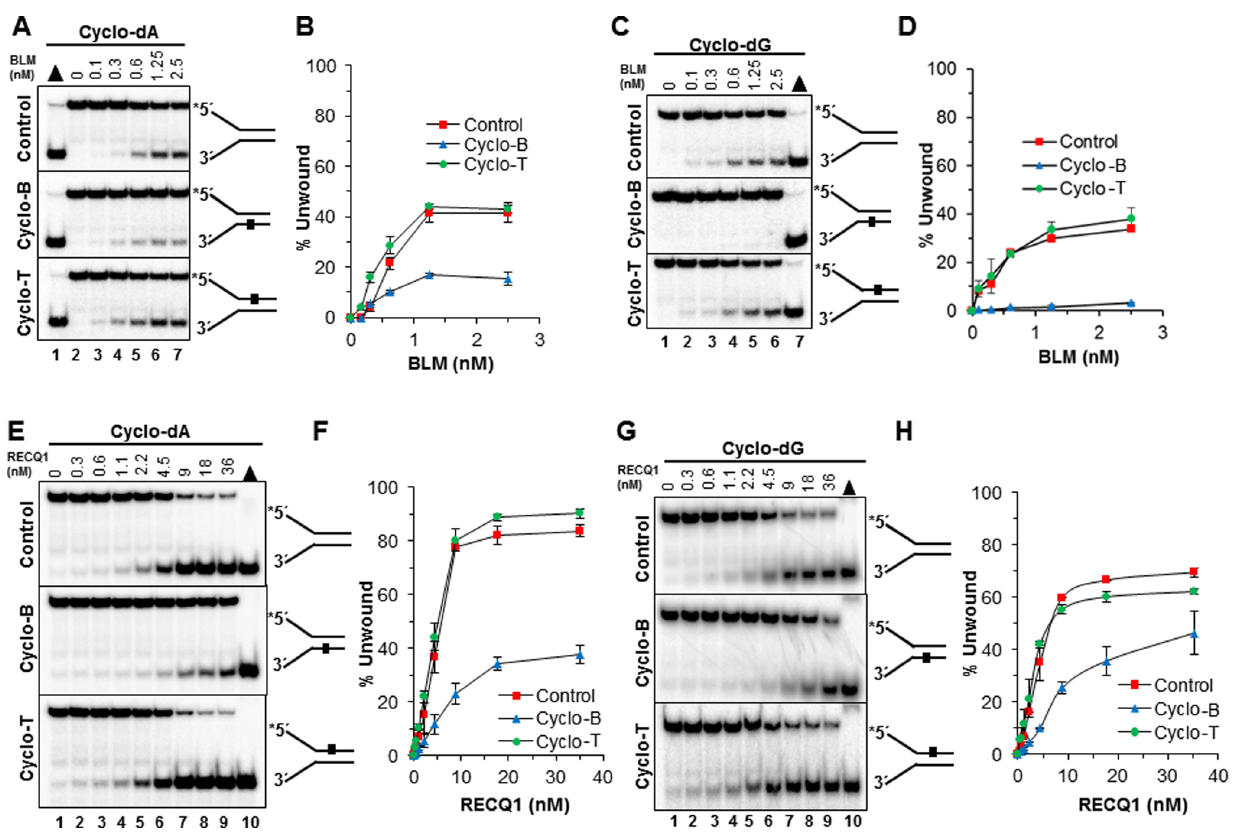
Figure 2. Effect of a site- and strand-specific cyclopurine lesion on BLM or RECQ1 helicase activity. Helicase reactions were carried out by incubating the indicated BLM or RECQ1 concentrations with 0.5 nM forked duplex DNA that contained a cyclopurine lesion in the top strand (nontranslocating-Cyclo T), bottom strand (translocating-Cyclo B), or neither strand (Control) at 37 u C for 15 min (RECQ1) or 30 min (BLM) under standard helicase assay conditions described in the Materials and Methods. A, BLM unwinding of undamaged and cyclo dA damaged DNA substrates. Lane 1, heat-denatured DNA substrate control; lane 2, no enzyme control; lanes 3–7, indicated concentrations of BLM. B, Quantification of BLM helicase activity on cdA substrates with error bars. C, BLM unwinding of undamaged and cyclo dG damaged DNA substrates. Lane 1, no enzyme control; lanes 2–6, indicated concentrations of BLM, lane 7 heat-denatured DNA substrate control. D, Quantification of BLM helicase activity on cdG substrates with error bars. E, RECQ1 unwinding of undamaged and cyclo dA damaged DNA substrates. Lane 1, no enzyme control; lanes 2–9, indicated concentrations of RECQ1; lane 10, heat-denatured DNA substrate control. F, Quantification of RECQ1 helicase activity on cdA substrates with error bars. G, RECQ1 unwinding of undamaged and cyclo dG damaged DNA substrates. Lane 1, no enzyme control; lanes 2–9, indicated concentrations of RECQ1; lane 10, heat-denatured DNA substrate control. H, Quantification of RECQ1 helicase activity on cdG substrates with error bars.